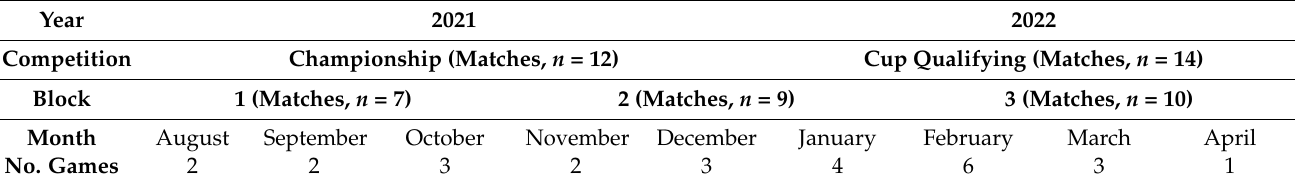
Figure 2. Mean ± 95% IC estimates for total distance ( A ), HSR distance ( B ), sprint distance ( C ), exposure time ( D ), and number of accelerations ( E ) and decelerations ( F ) throughout the first block (black bars), second block (white bars), and third block (grey bars). * significantly different from starters; § significantly different from fringe. The number of observations ( n ) for each condition is presented below the respective group. Abbreviations: HSR—high-speed running. Table 1. The layout of the 2021/2022 competitive soccer season